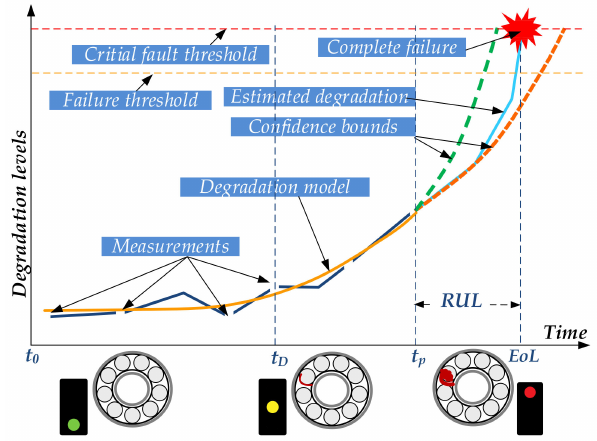
Figure 6. Illustration of the prognostics